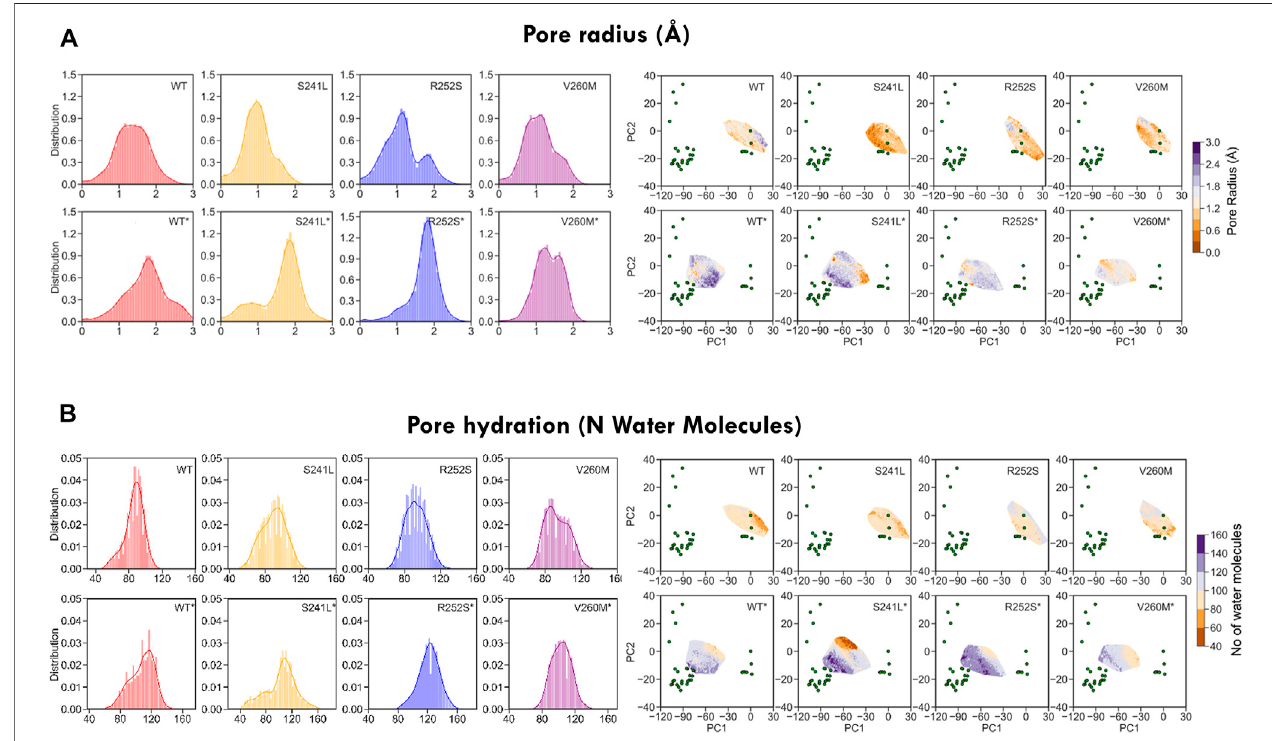
FIGURE 7 | Minimum pore radius (A) and hydration (B) calculated for WT and mutant GlyR from MD simulations. While WT simulations display Gaussian-like distributions of both pore radius and hydration, mutations shift them toward the right and/or split them in multiple sub-peaks suggestive of enlarged and more hydrated pore states. See average values in Supplementary Table S3